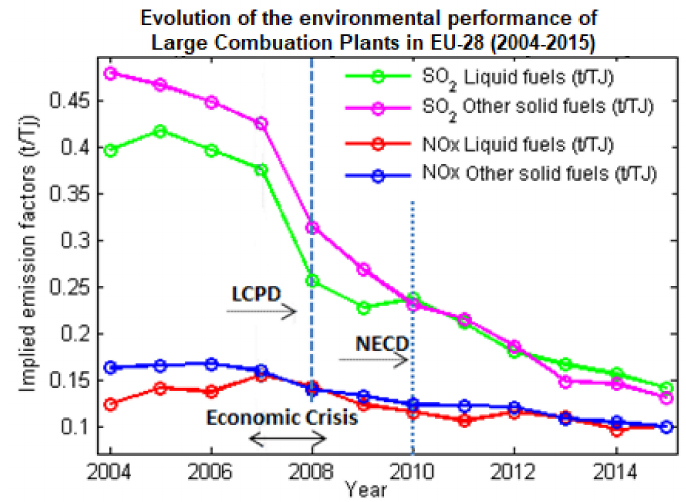
Figure 1. Evolution of the environmental performance of large combustion plants in the EU-28, expressed as implied emission factors for SO 2 and NOx by fuel